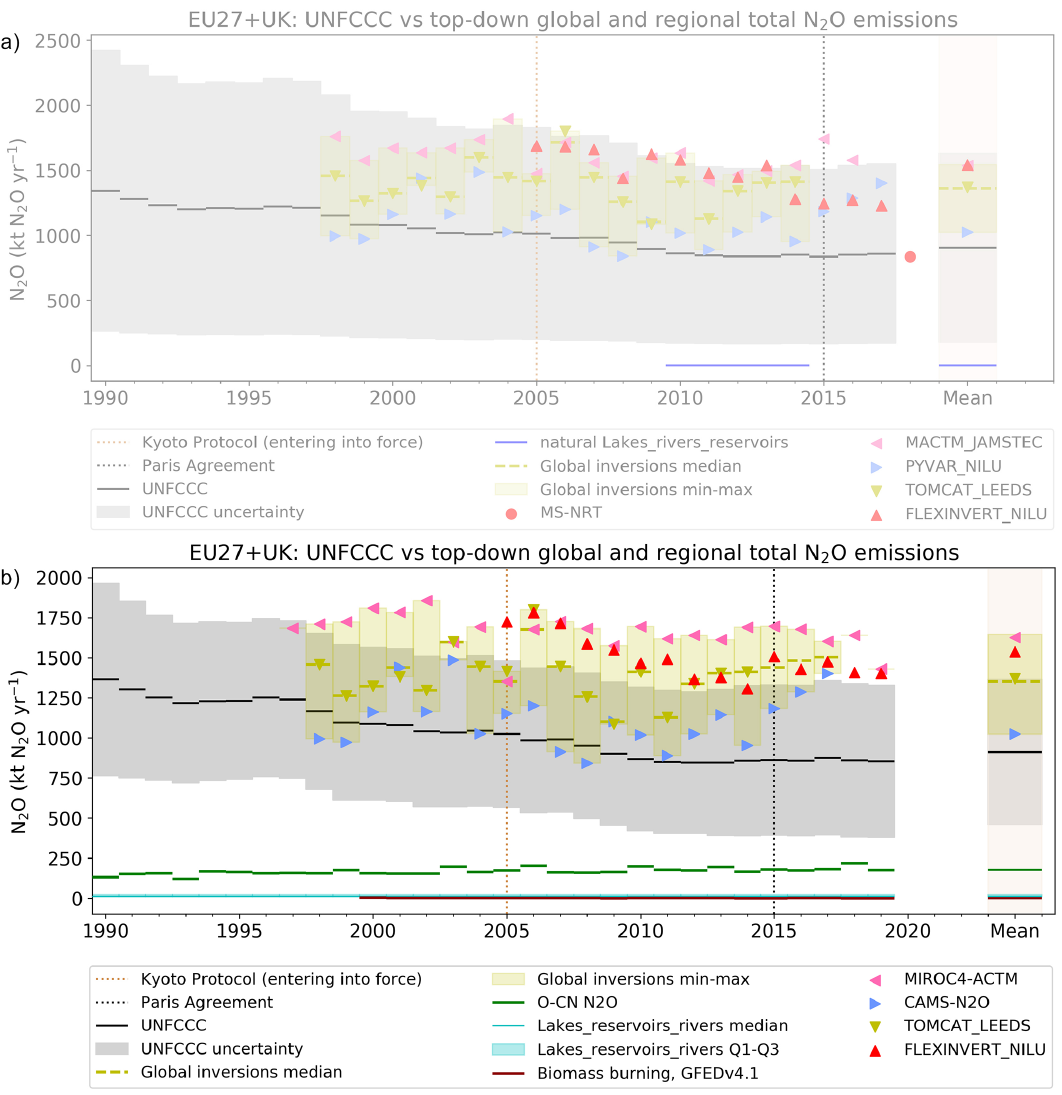
Figure 13. Comparison of total N 2 O emissions for the EU27 + UK from one top-down regional inversion (FLEXINVERT) and three inversions (TOMCAT, CAMS-N 2 O and MIROC4-ACTM) with UNFCCC NGHGI (gray) data and natural N 2 O emissions (lakes, reservoirs and rivers from RECCAP2; natural pre-industrial soil emissions from the O-CN model; and biomass burning from GFEDv4.1) as follows: panel (a) shows the previous synthesized data in Petrescu et al. (2021), and panel (b) depicts data synthesized by the current study. The relative error on the UNFCCC value represents the UNFCCC NGHGI (2021) member-state-reported uncertainties computed with the error propagation method (95% confidence interval) that were gap-filled and provided for every year (including LULUCF). The last years of the time series of the respective datasets are 2014 (TOMCAT), 2017 (CAMS-N 2 O) and 2019 (UNFCCC, FLEXINVERT and MIROC4-ACTM). The mean column represents the common overlapping period (2005–2014) between datasets; MACTM-JAMSTEC and PYVAR_NILU in panel (a) are the same as MIROC4-ACTM and CAMS-N 2 O in panel (b)